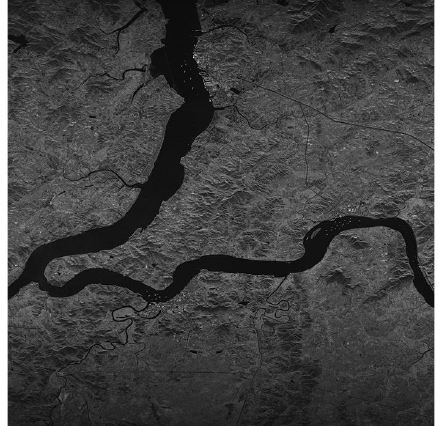
Figure 15. Imaging result of the system hardware.